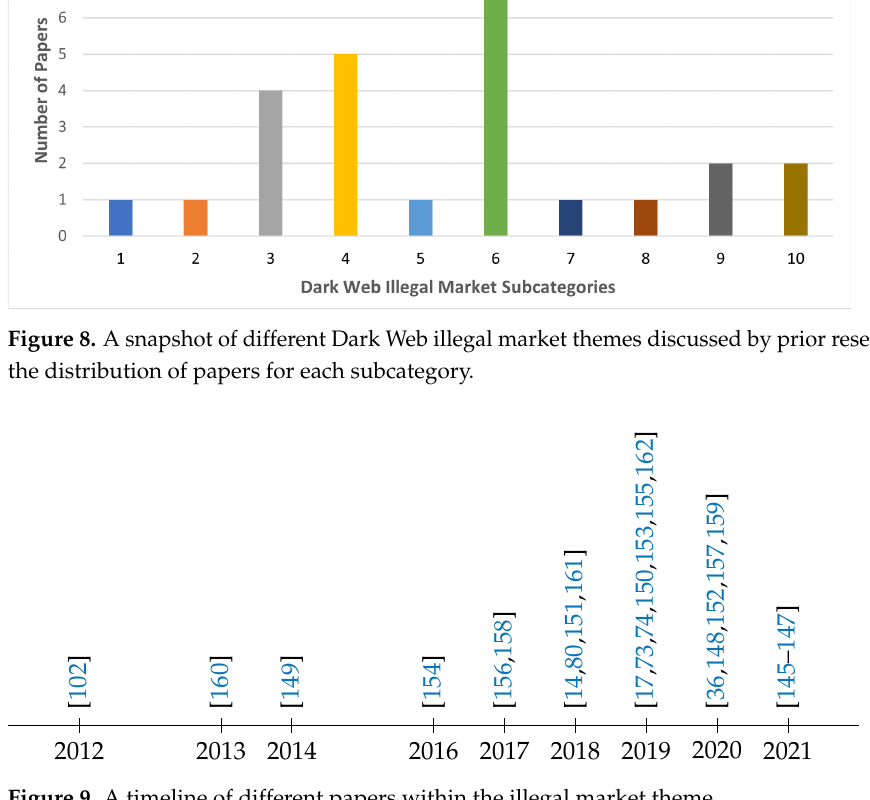
Figure 9. A timeline of different papers within the illegal market